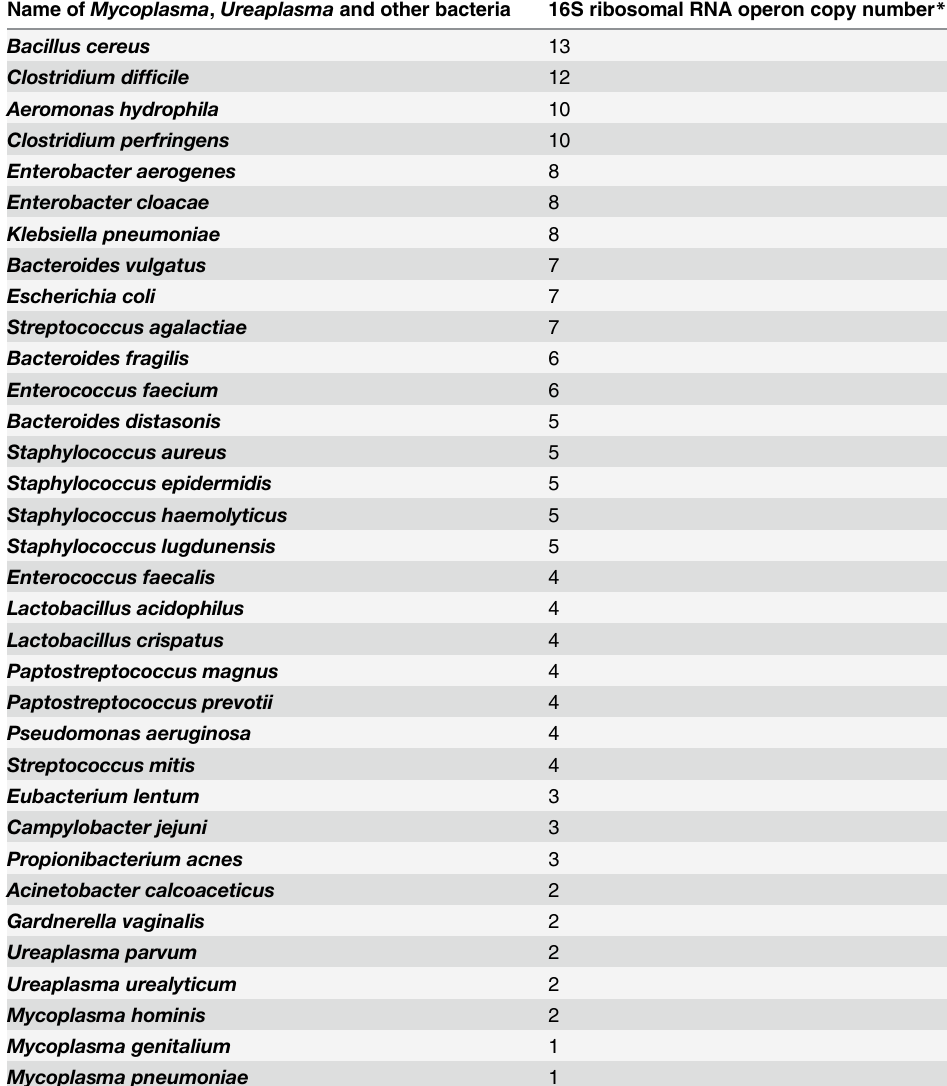
Table 4. The variations of the 16S ribosomal RNA operon copy number in genomes. Name of Mycoplasma , Ureaplasma and other bacteria 16S ribosomal RNA operon copy number